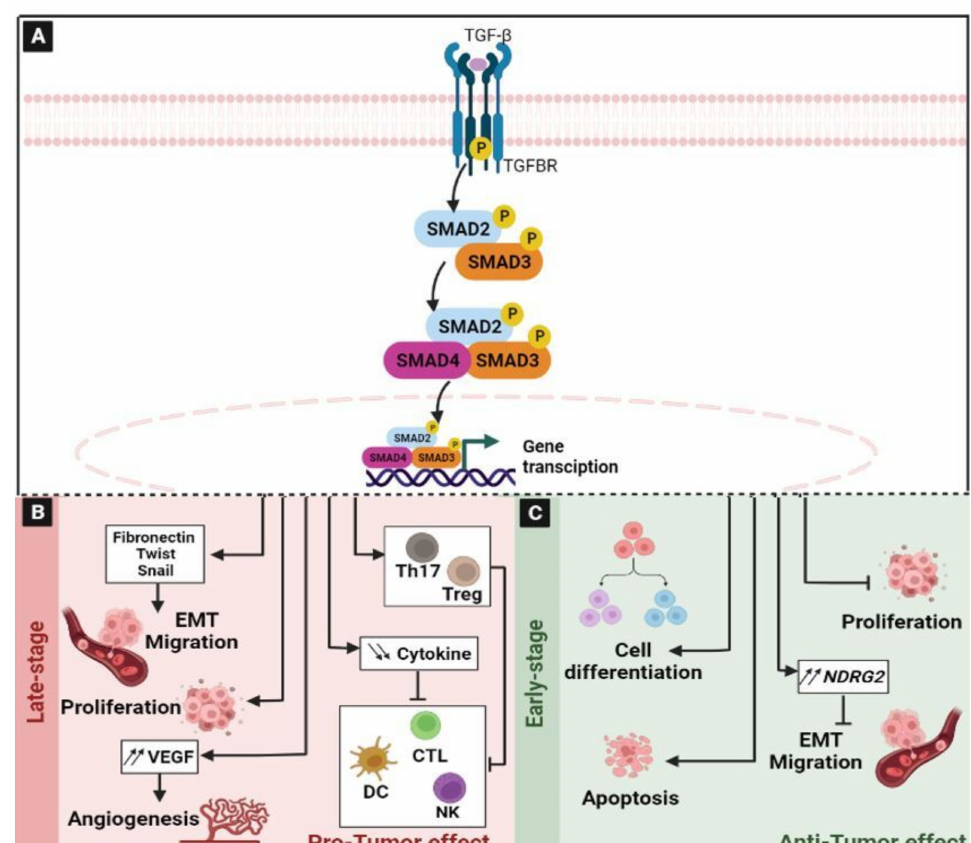
Figure 6. The paradoxical role of TGF- β signaling pathway in colorectal cancer. ( A ) Schematic repre- sentation of activated TGF- β pathway: The ligation of TGF- β to the receptor induces the formation of a heterotetrameric complex of TGFBRs. The activation of TGFBR1 by phosphorylation leads to phosphorylating the SMAD2/3, which can be assembled into complexes with SMAD4. Then, the complex is translocated to the nucleus where it can regulate the expression of target genes. ( B ) During the late stage, TGF- β acts as an oncogene and increases tumor proliferation. It induces the EMT, accelerating tumor invasion and metastasis through Fibronectin, Twist, and Snail. In addition, TGF- β enhances the expression of VEGF, inducing angiogenesis. TGF- β decreases cytokine production, thereby suppressing the immune system and inducing cell differentiation into Treg and Th17. ( C ) At the early stage of cancer, TGF- β acts as a tumor suppressor by inhibiting cell proliferation and EMT. It also induces apoptosis and stimulates cell differentiation. Abbreviations: TGFBR: